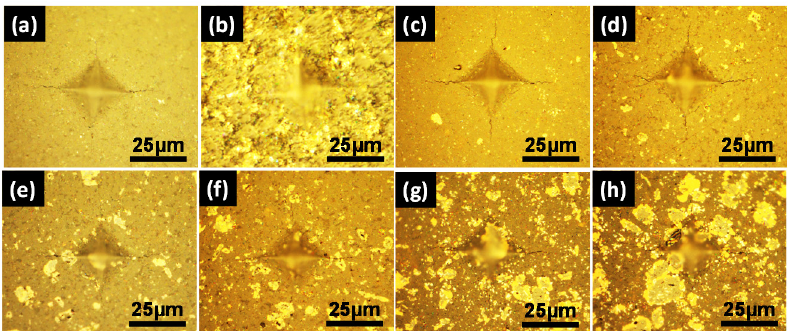
Figure 5. Optical micrographs of the Vickers hardness indents and the induced cracks in ( a ) Si 3 N 4 -7 wt.% (Al 2 O 3 -Y 2 O 3 ), ( b ) Si 3 N 4 -3 vol.% Ti 3 SiC 2 , ( c ) Si 3 N 4 -5 vol.% Ti 3 SiC 2 , ( d ) Si 3 N 4 -10 vol.% Ti 3 SiC 2 , ( e ) Si 3 N 4 -15 vol.% Ti 3 SiC 2 , ( f ) Si 3 N 4 -20 vol.% Ti 3 SiC 2 .